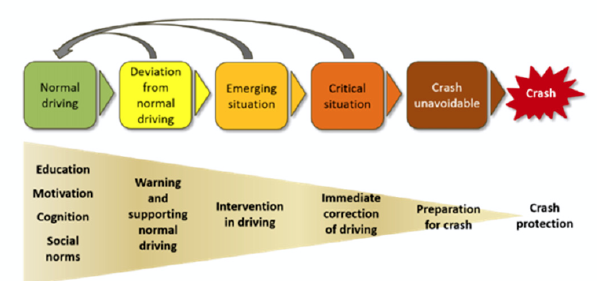
Figure 2 Overview of the chain of events leading up to a crash, from Rizzi